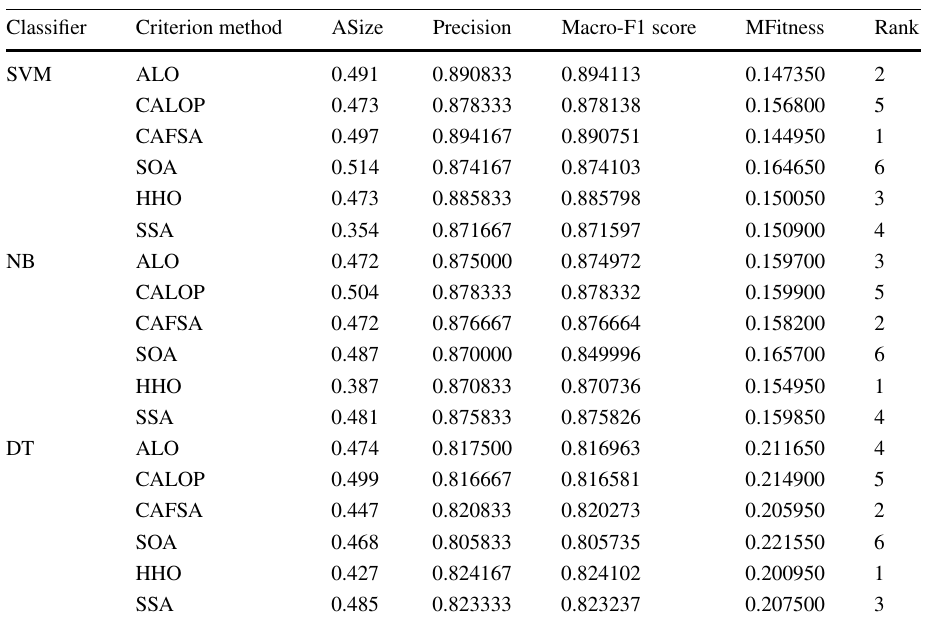
(d) Average fitness of the three classifiers